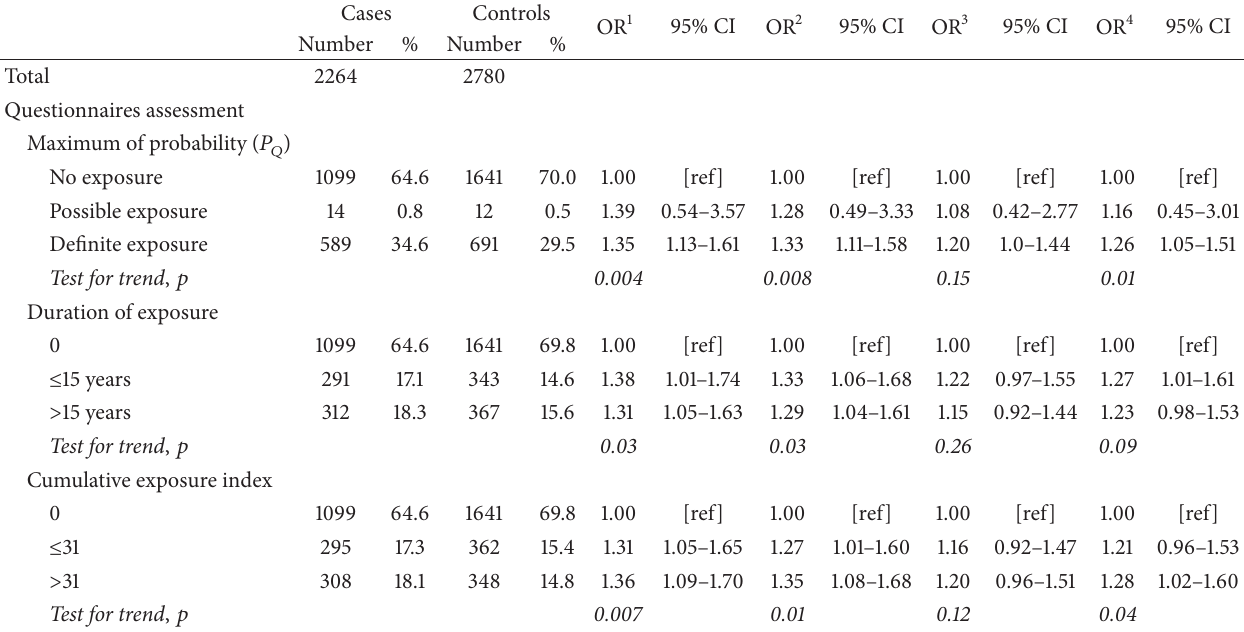
Table 3: OR of lung cancer according to diesel motor exhaust (DME) exposure assessed by the